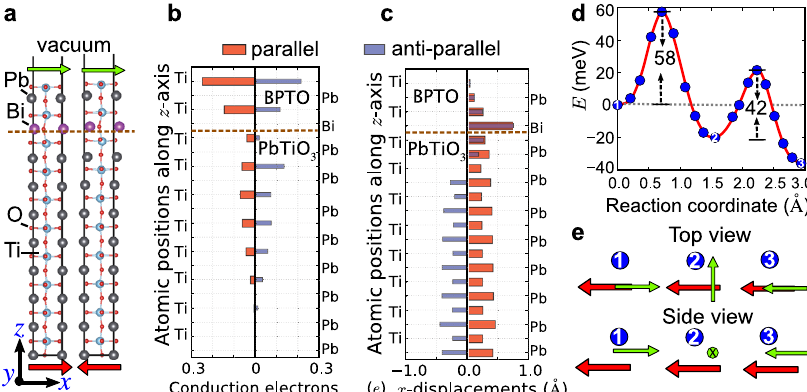
Fig. 5 Switching of polar displacements of BPTO in a BPTO/PbTiO 3 heterostructure. a Atomic structure of the BPTO/PbTiO 3 heterostructure: “ parallel state ” (left) and “ anti-parallel state ” (right). The red (green) arrow refers to PbTiO 3 polarization (BPTO polar displacement). b Layer-resolved conduction electrons on each Ti atom in parallel and anti-parallel states. c Layer-resolved polar displacements of metal ions along the x -axis in parallel and anti-parallel states. In a , b and c , the brown dashed lines indicate BPTO/PbTiO 3 interface. d Calculated energy barrier along the transition path from the anti-parallel state to the parallel state. The energy of anti-parallel state is set as the zero point. The black dashed arrows highlight two energy barriers. The blue circles represent the images on the transition path found in the nudged elastic band calculations. The three energy minima along the transition path are schematically shown in e : “ 1 ” is the anti-parallel state, “ 3 ” is the parallel state and “ 2 ” is a metastable state with BPTO polar displacements perpendicular to PbTiO 3 polarization in the xy